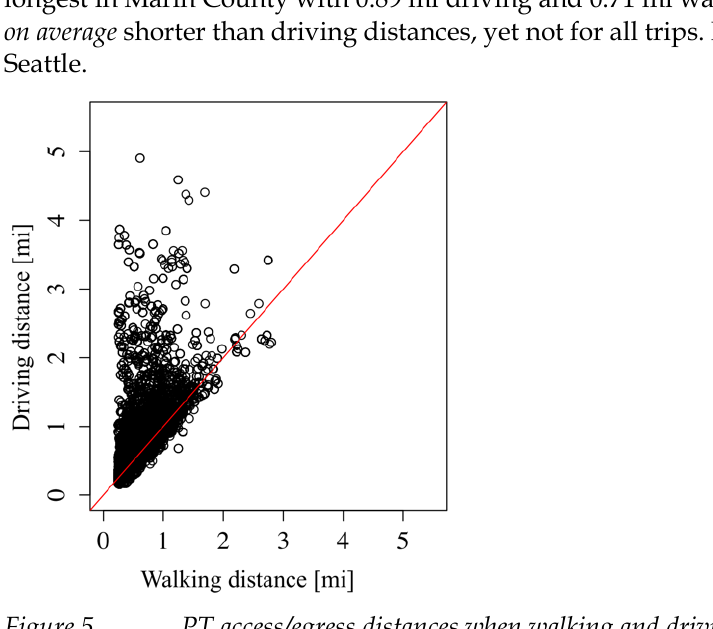
Figure 5. PT access/egress distances when walking and driving in